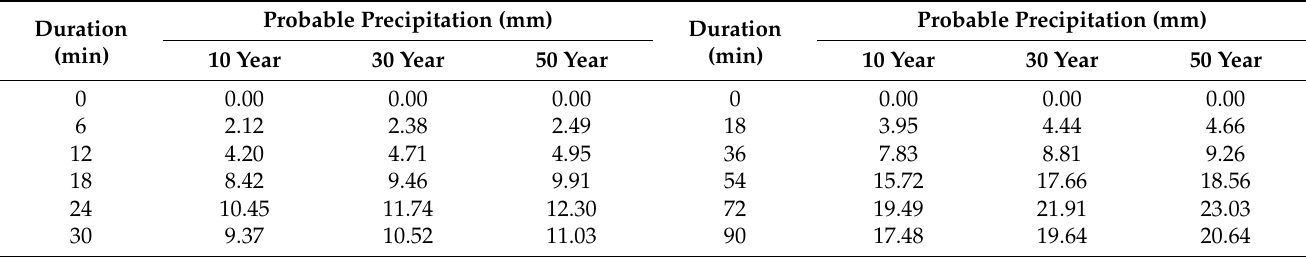
Table 2. Designed probable precipitation with the frequency of 10, 30, and 50 years and duration of 1 h (60 min) to 12 h (720